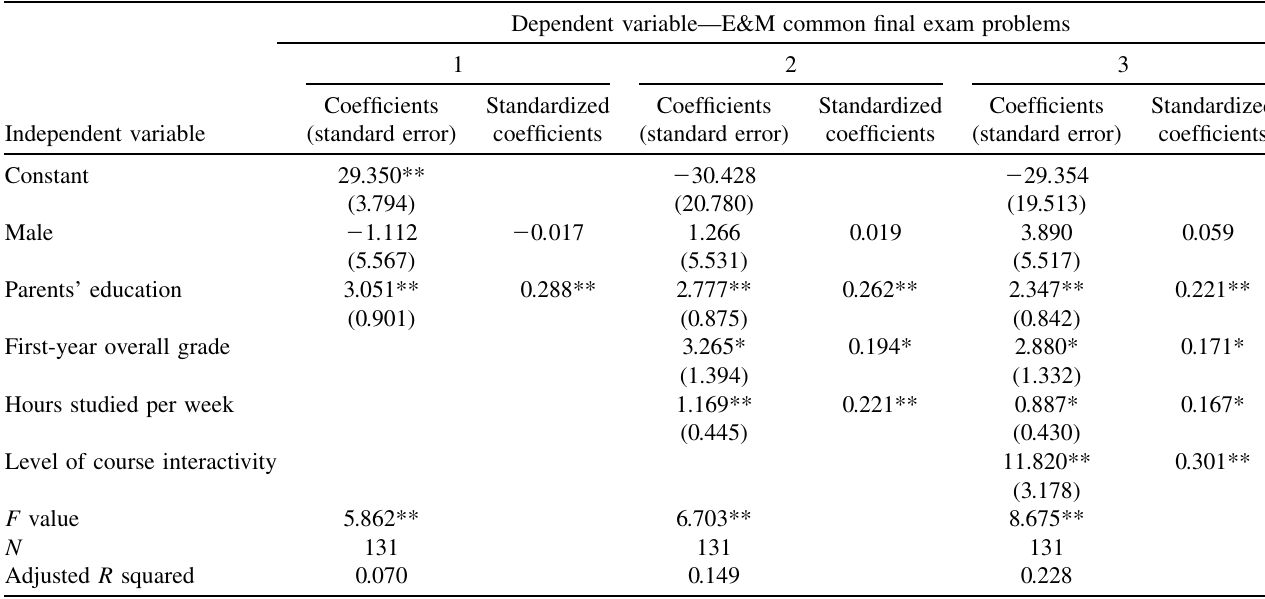
TABLE VI. E&M common final exam—Models 1–3 (* p < 0 : 05 , ** p < 0 : 01 ).